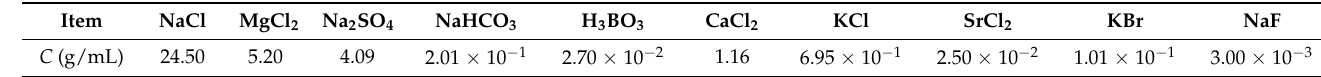
Table 1. Chemical compositions of ASTM D1141-2013 ASW.